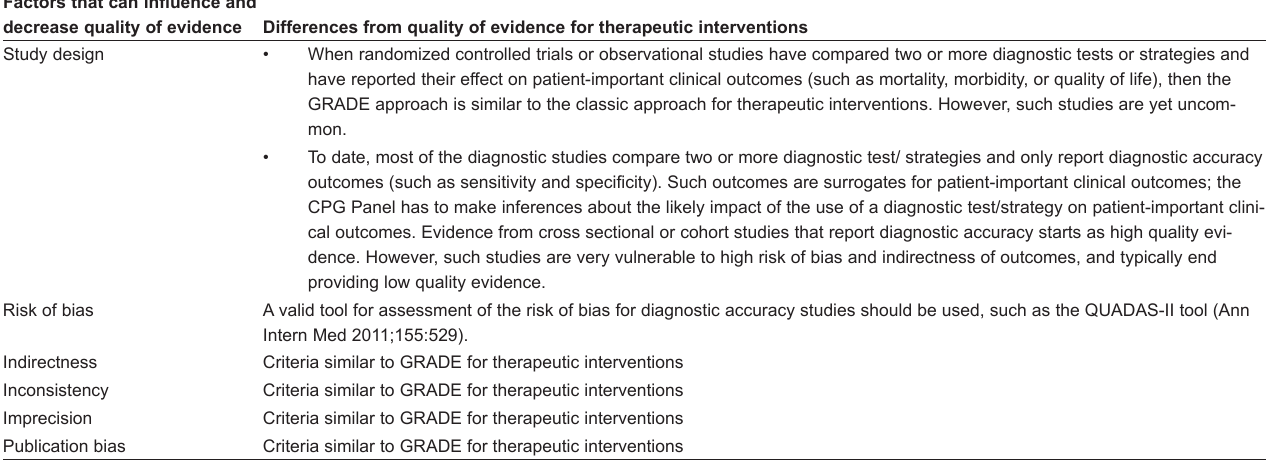
TAble 2 Grading of Recommendations Assessment, Development and evaluation (GRADe) for diagnostic tests/strategies; differences from GRADe for therapeutic interventions* Factors that can influence and decrease quality of evidence Differences from quality of evidence for therapeutic